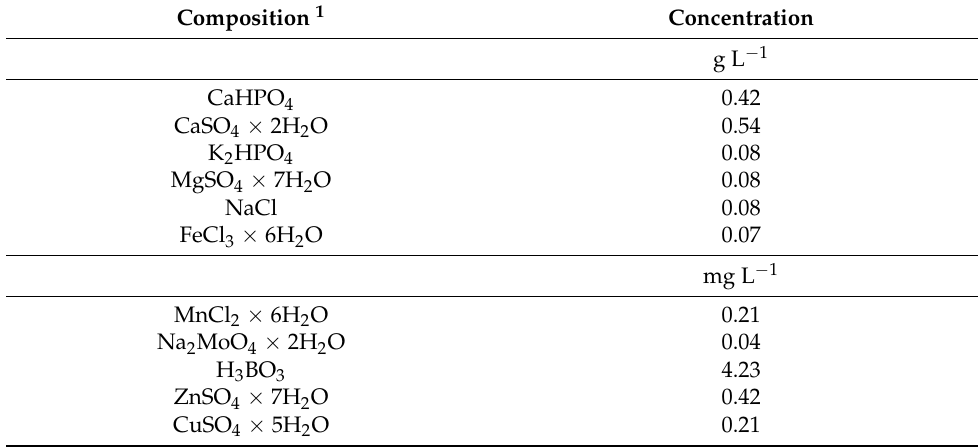
Table 2. Modified Jensen mineral solution composition used for soybean plant